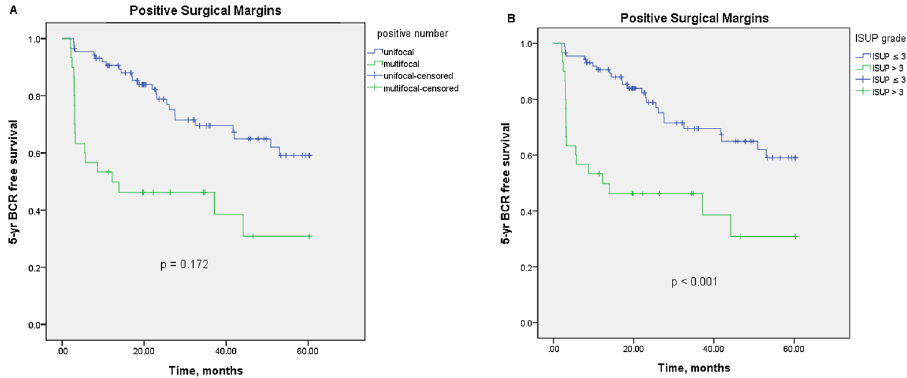
Figure 2. Kaplan–Meier curve for 5-year biochemical recurrence (BCR)-free survival in cases with positive surgical margins ( A ) stratified by unifocal and multifocal positive al margins ( p = 0.172); ( B ) stratified by ISUP grade > 3 and ISUP grade ≤ 3 ( p < 0.001).